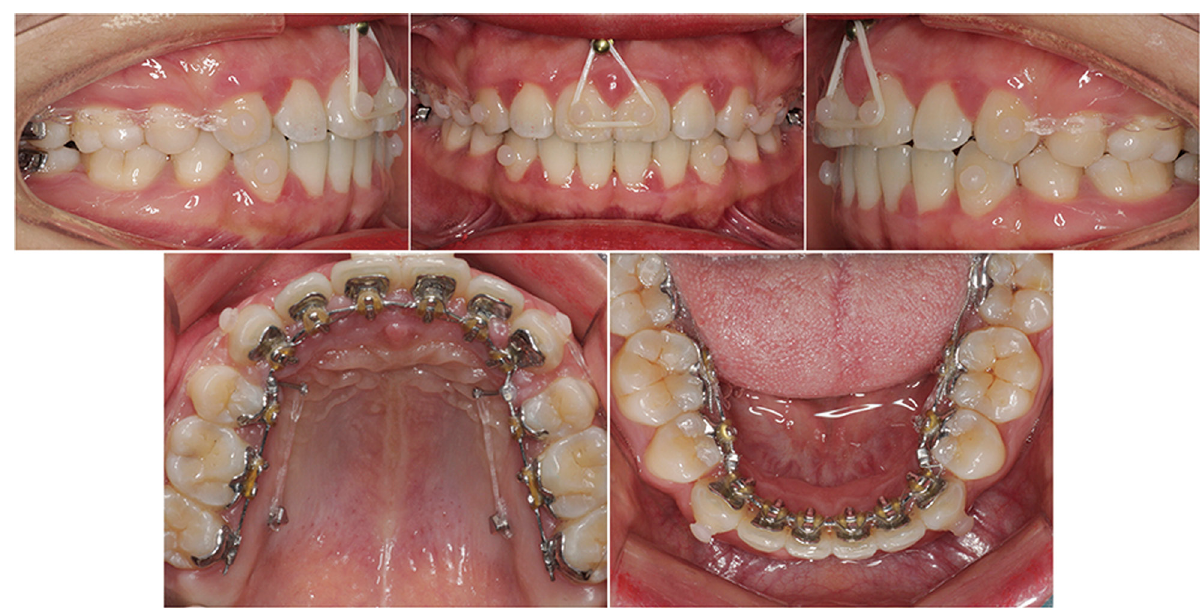
Figure 7. A micro-screw was inserted between maxillary central incisors in the mucogingival junction and assisted in intruding the anterior